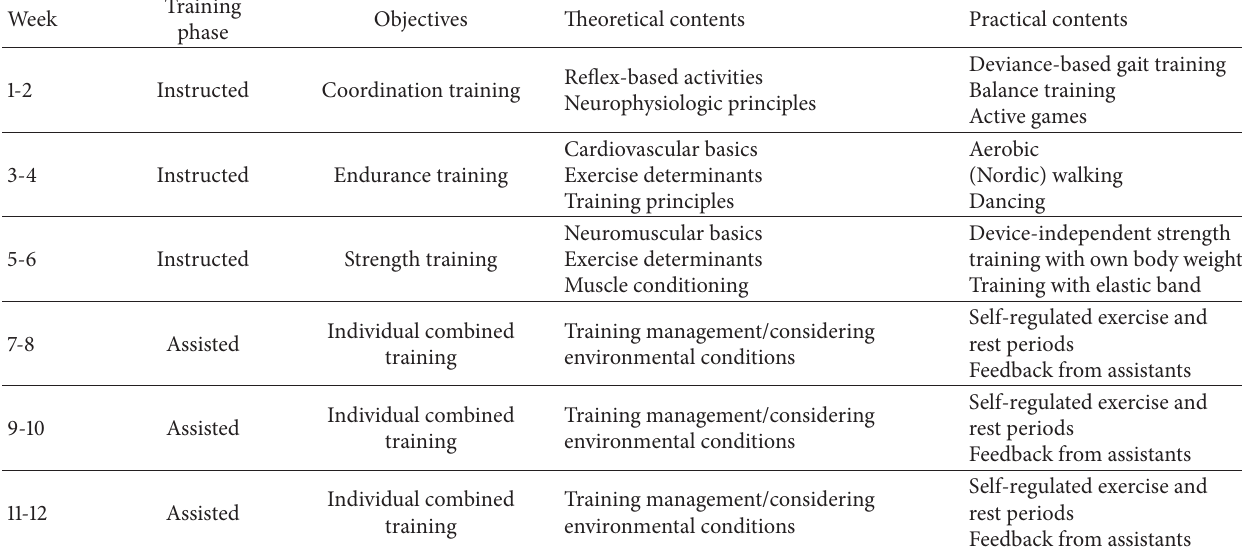
Table 2: Contents of the exercise-based patient education (in chronological